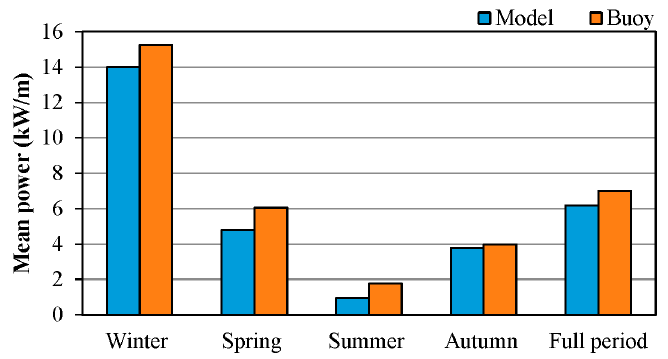
Figure 9. Seasonal wave power from buoy and SWAN model data in Gozo.